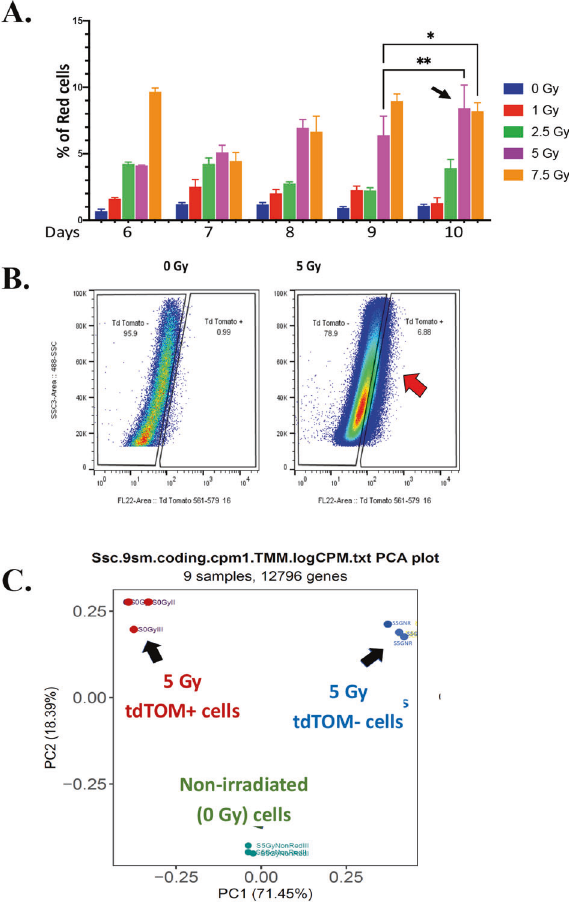
Fig. 1 Optimization of in vitro radiation induction of senescent tdTOMp16 + cells. A After 10 days, 5-Gy irradiated cells, plated at 50% con fl uency, yield ~9% of red (tdTOM + ) cells ( n = 4, * P = <0.5; ** P = <0.01. The statistical signi fi cance was calculated using one- way ANOVA with multiple comparison). B Irradiated (5 Gy) tdTOM + and irradiated (5 Gy) tdTOM − cells were FACS sorted using gating relative to non-irradiated cells. C PCA analysis from RNA-seq using three groups of cells (irradiated tdTOM + , irradiated tdTOM − and non-irradiated cells) show distinct separation in their gene expres- sion and similarity of the three replicates ( n = 3). We sequenced the transcriptomes of triplicate isolates of three groups of cells: irradiated tdTOM + senescent cells (0.32 × 10 6 cells each) replicate, irradiated tdTOM- non-senescent cells (2 × 10 6 cells), and non- irradiated cells (5 × 10 6